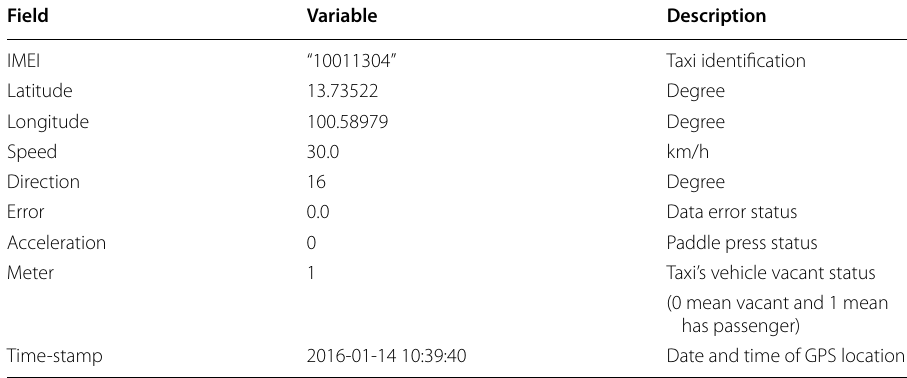
Table 1 Structure of the taxi GPS data collected from real driving vehicles in